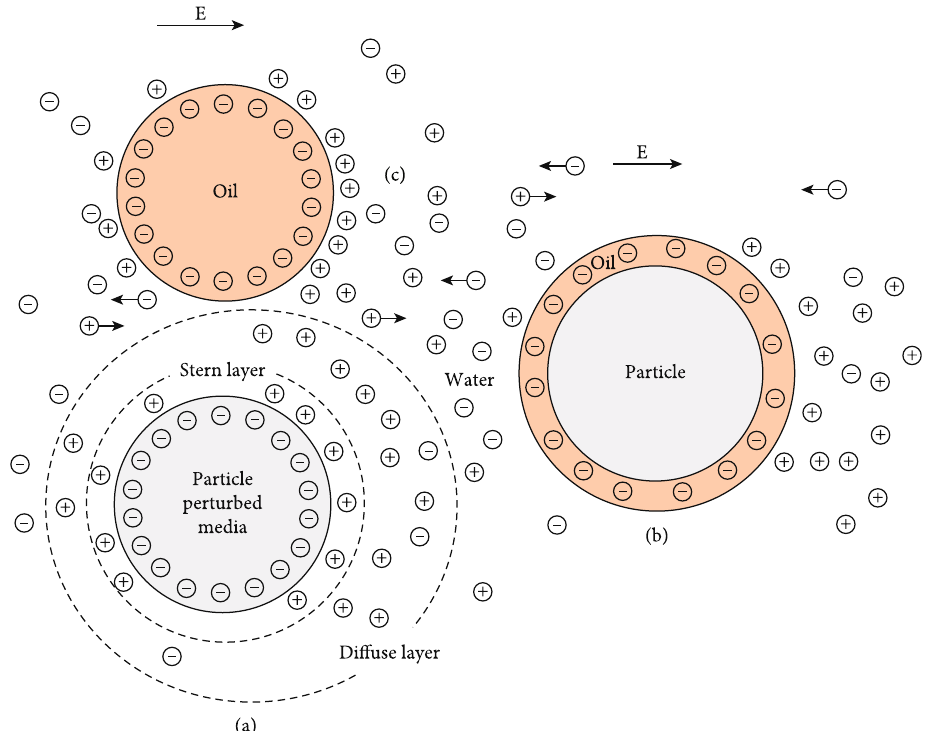
Figure 1: Diagram showing the distribution of the electric double layer under di ff erent wettability conditions: (a) the electric double layer distribution under hydrophilic conditions, (b) the electric double layer distribution under lipophilic conditions, and (c) the electric double layer at the oil-water interface [22]. Table 1: Basic information about rock